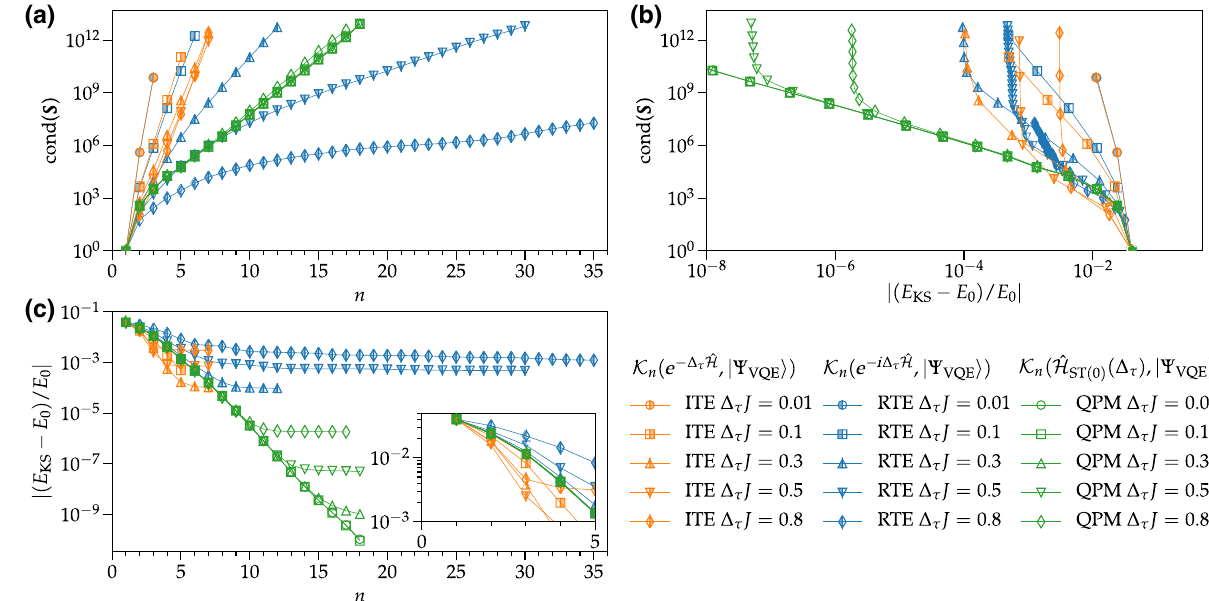
FIG. 11. Same as Fig. 9 but with the first-order Richardson extrapolation ( r = 1) for